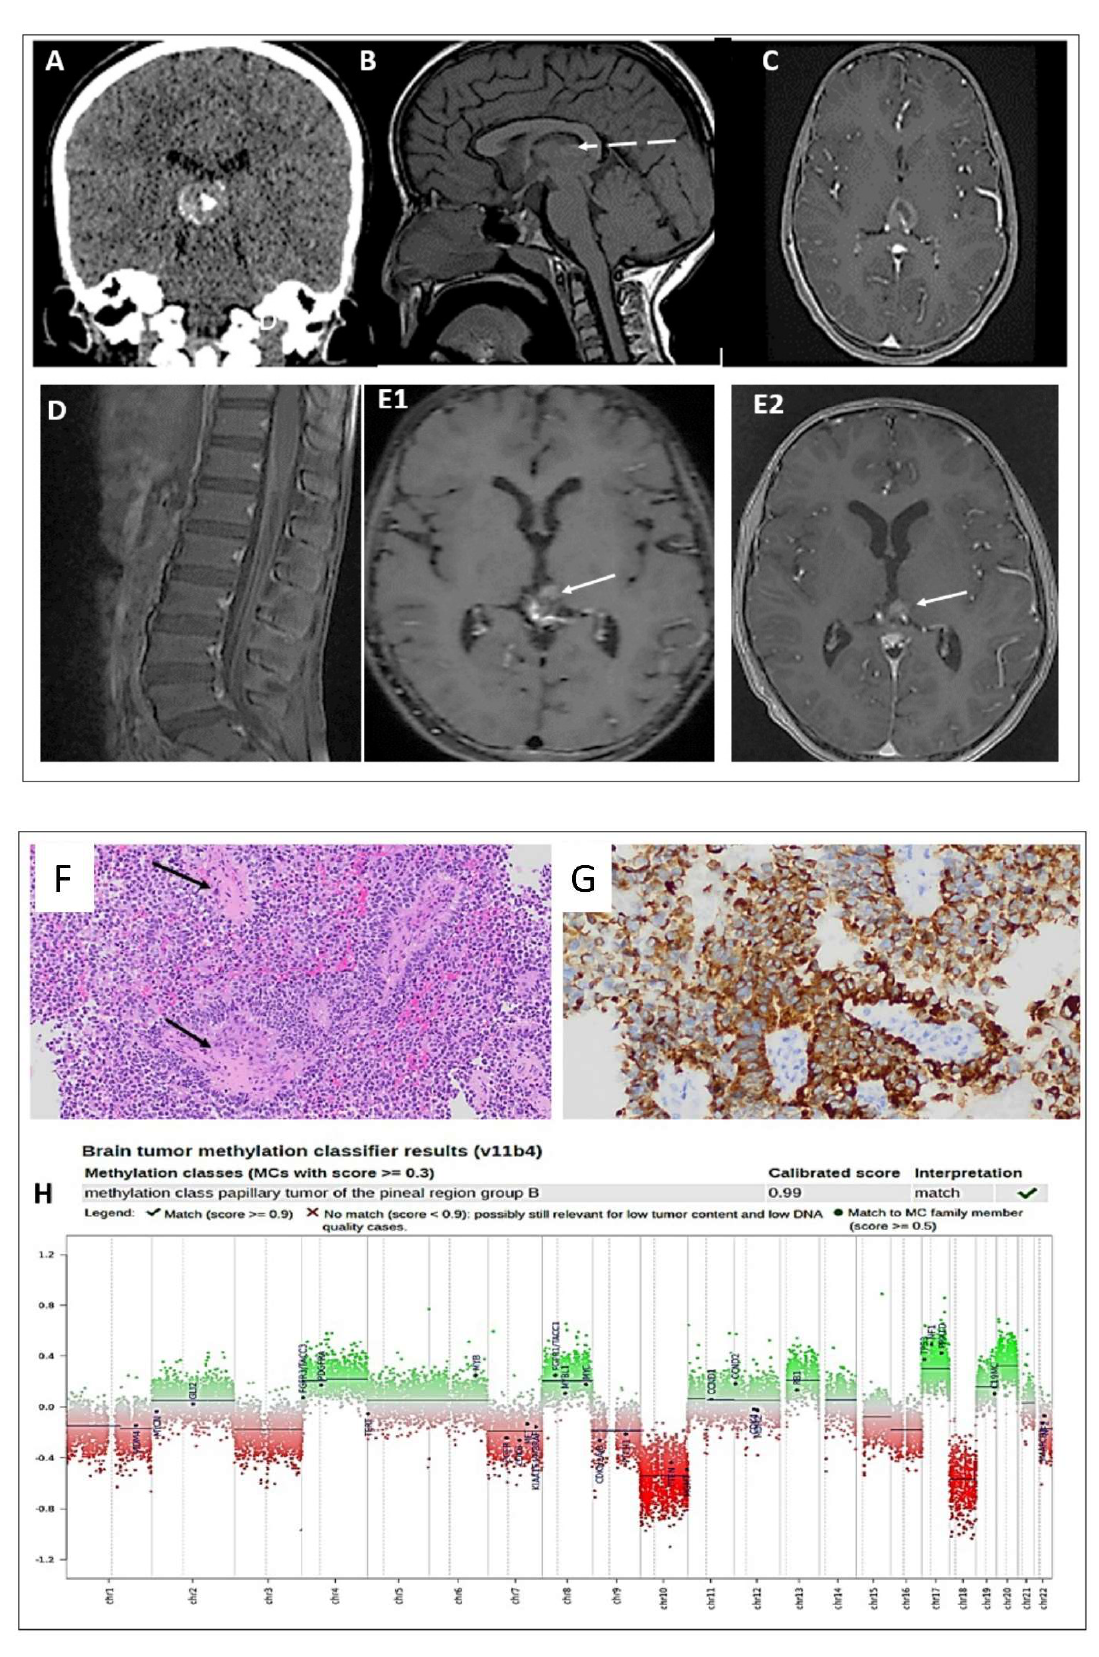
Figure 1. ( A ) CT scan shows a hyperdense lesion with a focus of central calcification. ( B ) SE